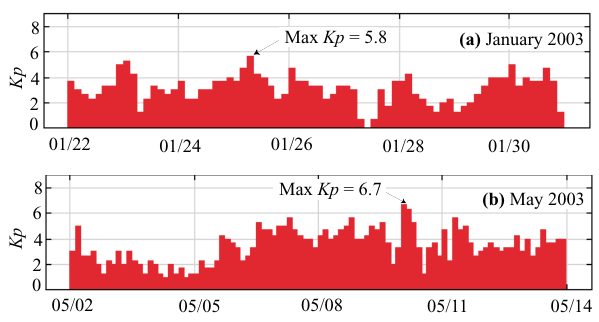
Fig. 5. Average planetary K p index, as recorded for dates studied. (a) Display of the K p index during the end of January. (b) Display of the K p index during the beginning of May. Each value of K p represents a 3-h average number derived from the standardized K index ( Ks ) of 13 magnetic